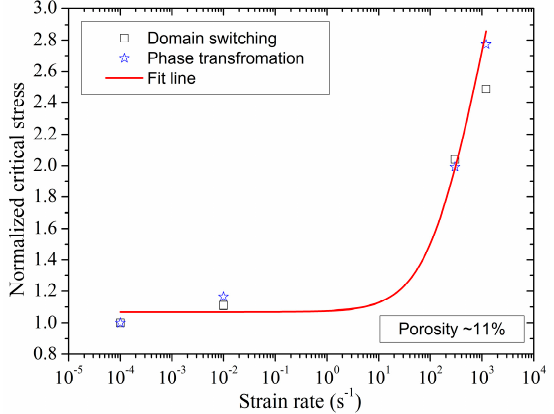
Figure 17. Normalized critical stress of domain switching and phase transformation as a function of strain rate for porosity poled PZT95/5 ceramics.